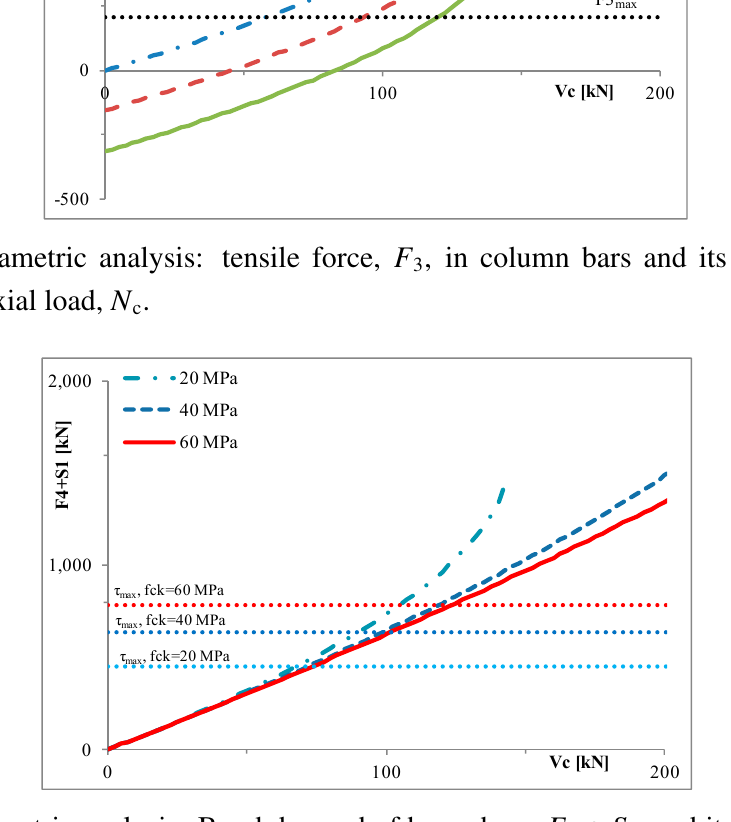
Figure 6. Parametric analysis: Bond demand of beam bars, F 4 + S 1 , and its threshold with variability of concrete strength, f c .